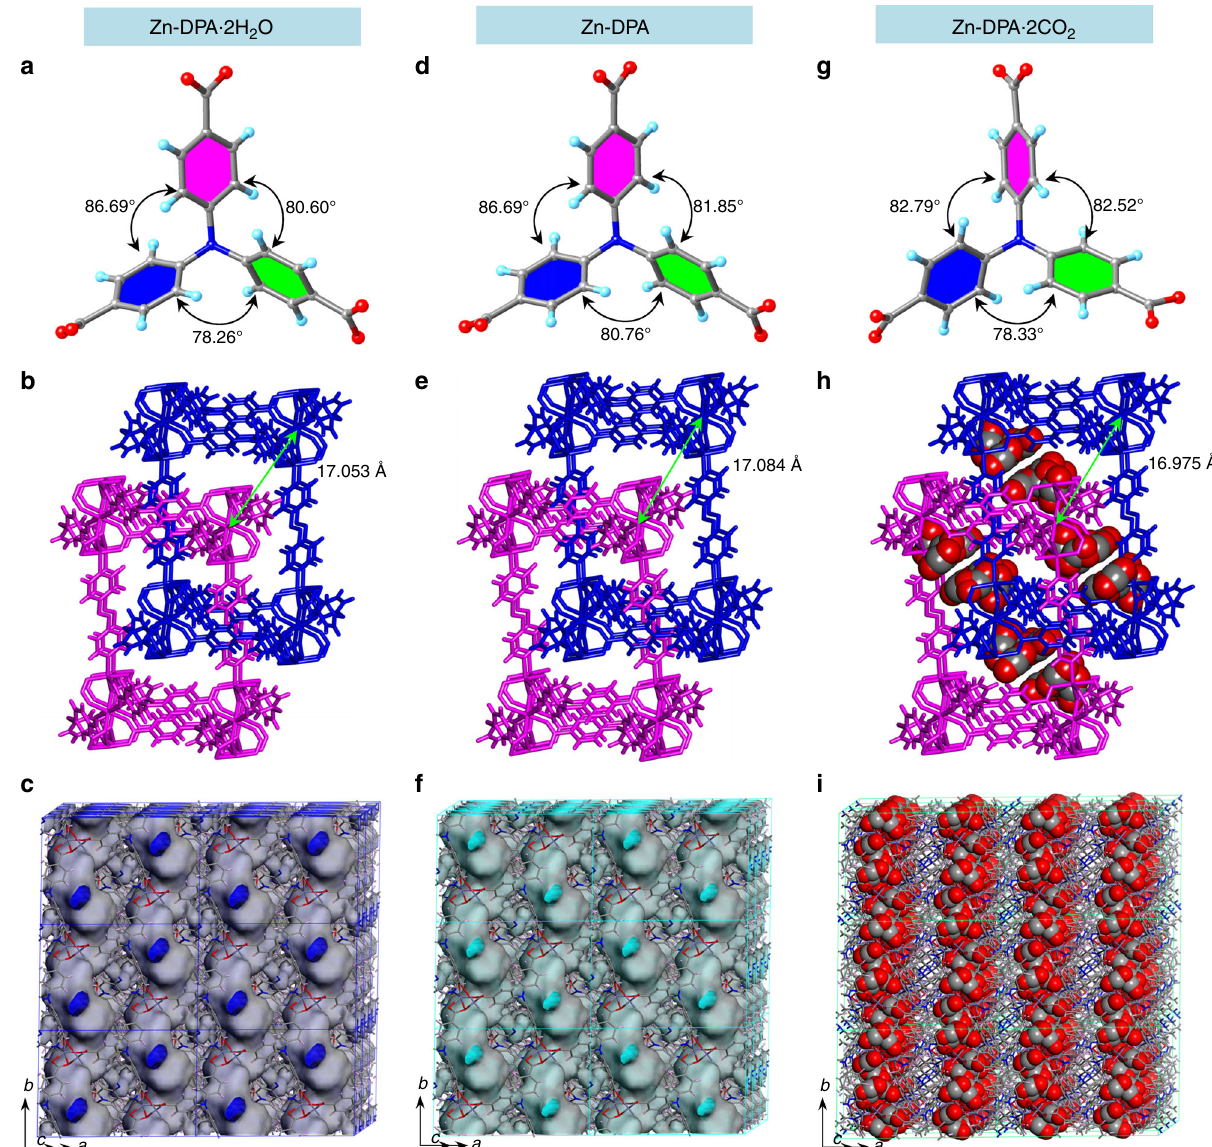
Fig. 1 X-ray crystal structure analyses. Crystal structures of as-synthesized Zn -DPA ·2H 2 O a – c , guest-free Zn -DPA d – f , and CO 2 -containing Zn -DPA ·2CO 2 g – i . The dihedral angle between two phenyl rings relative to each other in tca 3 − ligands found in PCPs a , d , g . The two-fold interpenetrated frameworks composed of a trinuclear Zn cluster, tca 3 − , and dpa ligands, showing the interlayer distance between the 2D sheets (measured between adjacent Zn cations from different sheets) b , e , h . Three-dimensionally connected channels in PCPs with Connolly surfaces (Connolly radius: 1.6 Å). The inner surfaces of the channels are shown in blue for c , cyan for f , and green for i , while the outer surfaces are represented in grey. Water molecules are omitted for clarity for Zn -DPA ·2H 2